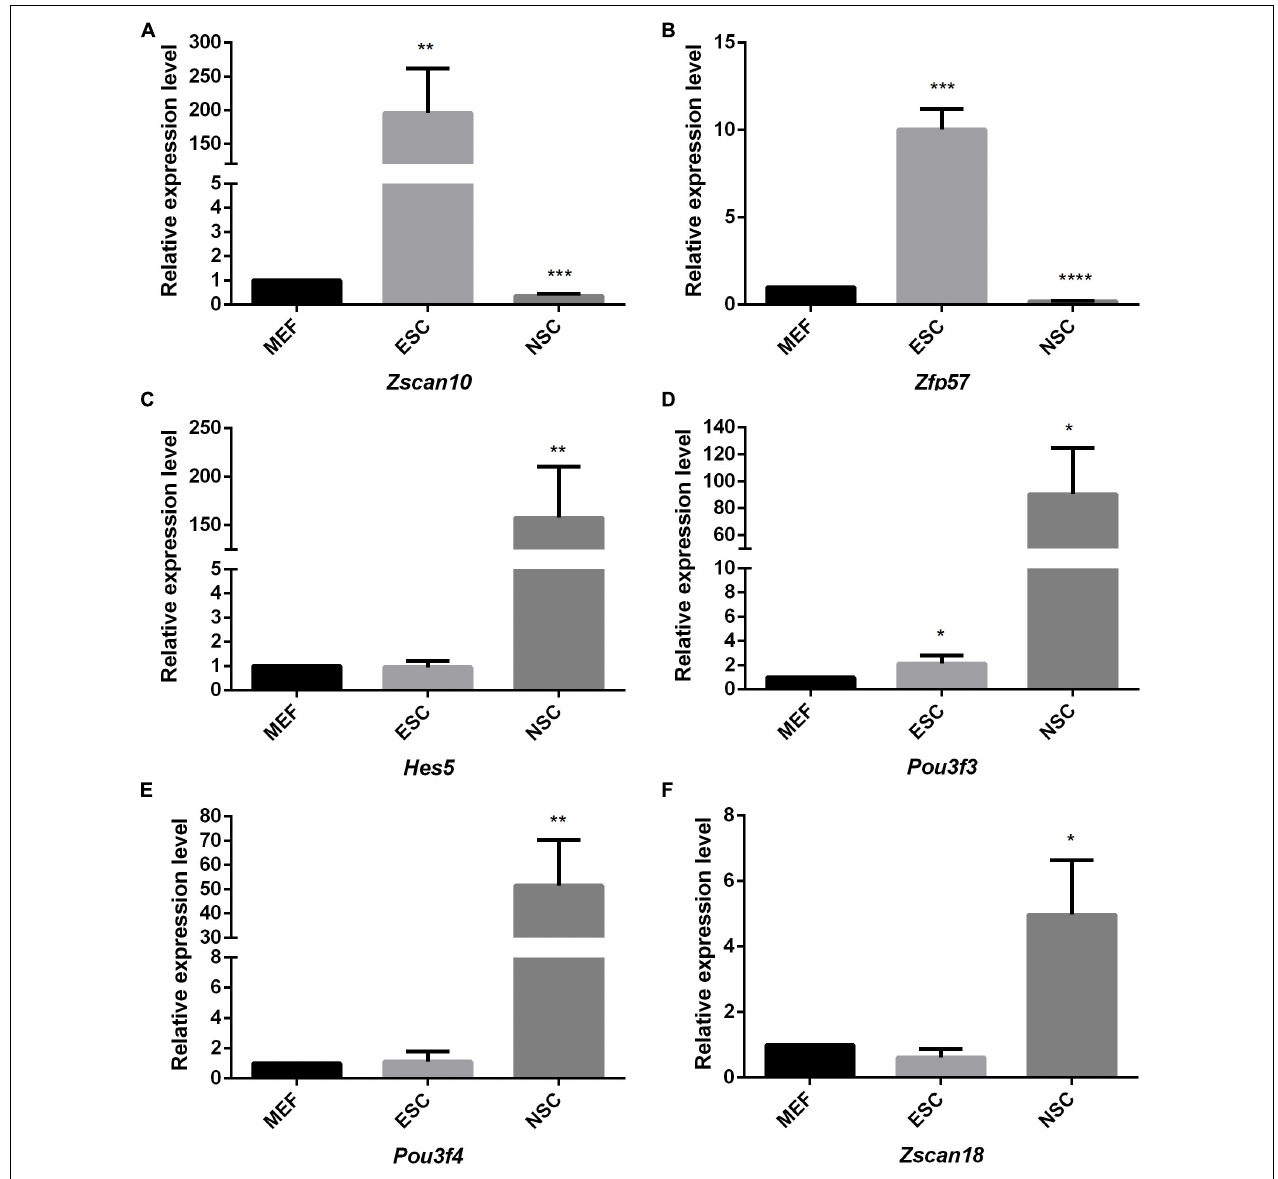
FIGURE 7 | The quantitative analysis of identified stem cell related genes based on qPCR (A–F) . The expression levels of identified stem cell related genes were detected in ESC and NSC. All data were normalized to the β -actin and are displayed as fold changes compared to MEF. Error bars are the standard deviation (SD) of at least three repeats. The significance of differences in multiple comparisons were determined by student’s t -test. “*” means p < 0.05, “**” means p < 0.01, “***” means p < 0.001, and “****” means p < 0.0001.